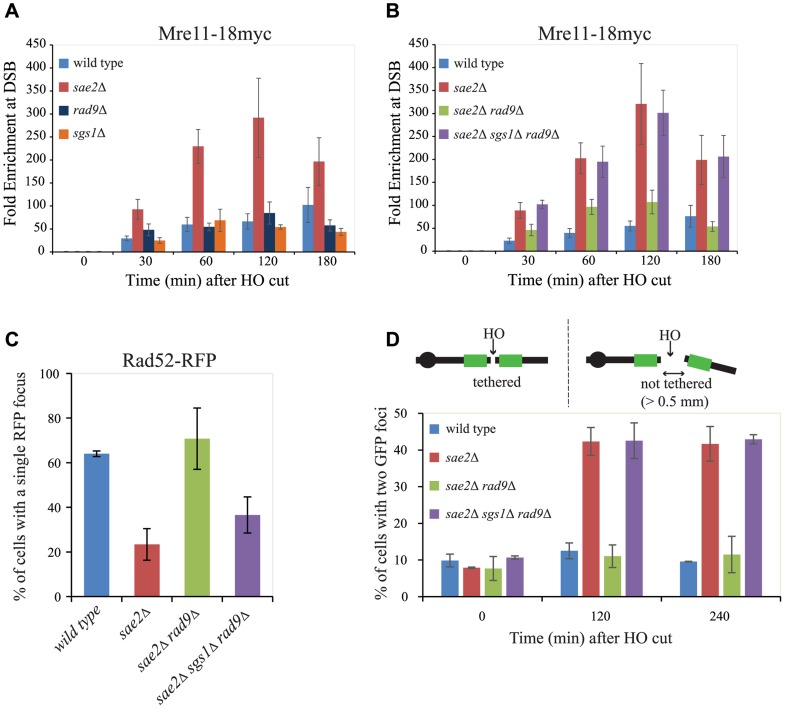
Rad9 limits Mre11 removal from a DSB, affecting Rad52 binding and DSB ends tethering in sae2Δ cells.(A, B) Cells of the wild type JKM139 strain and the indicated derivatives, expressing a Mre11–18Myc fusion protein, were grown in YEP+raf and synchronized in G2/M phases by nocodazole treatment. Galactose was added at time 0 to induce HO. Relative fold enrichment of Mre11–18Myc at 0.1 kb from the HO cleavage site was evaluated after ChIP with anti-Myc antibodies and qPCR analysis. Plotted values are the mean values ± SEM from three independent experiments. (C) Cells of the wild type JKM139 strain and the indicated derivatives, expressing a Rad52-RFP fusion protein, were grown in YEP+raf and synchronized in G2/M phases by nocodazole treatment. Galactose was added at time 0 to induce HO. After 6 hours from DSB, cells were imaged under live cell conditions for Rad52-RFP focus formation. Approximately 100 cells per experiment were analyzed and the percentage of cells displaying a detectable Rad52-RFP focus was quantitated. Error bars reflect ranges from two independent experiments. (D) Cells of the wild type yJK40.6 strain and the indicated derivatives, expressing a LacI-GFP and carrying two LacO arrays (green boxes) at 50 kb on either side of one HO cut site on chromosome VII (see a scheme above the graph in Fig. 4D and text for details), were grown in YEP+raf and blocked in G2/M phases by nocodazole treatment. Galactose was added at time 0 to induce HO. Cell samples taken at the indicated times after HO induction were analysed with a fluorescence microscope to determine the percentage of cells in each sample that contained two LacI-GFP foci separated by>0.5 µm. The separation distance between foci was measured for 200 cells/sample.